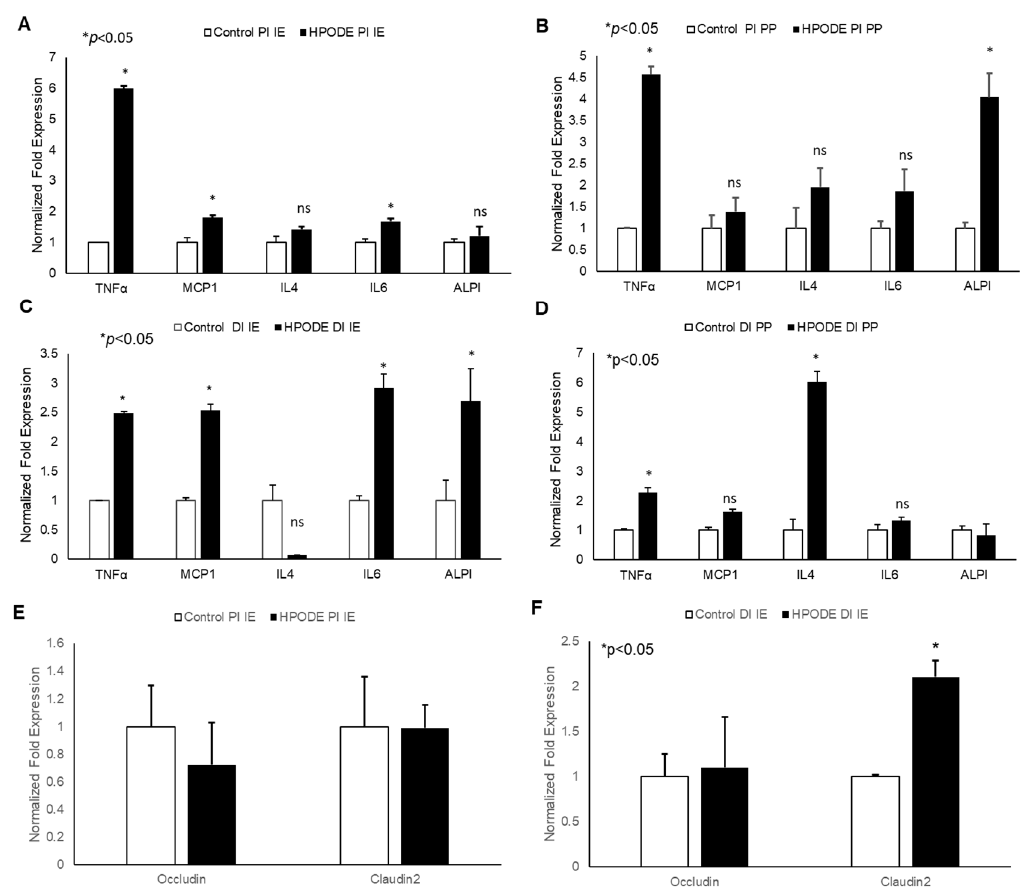
Figure 4. Acute effect of 13-HPODE on murine proximal and distal IE and PP. In acute studies, C57BL/6J mice received either PBS (control group) or 13-HPODE (HPODE group) via oral gavage and were euthanized after 4 h. Following sacrifice, the small intestine was collected, proximal (PI) and distal (DI) portions were separated, from which intestinal epithelium (IE) and Peyer’s patches (PP) were collected. ( A , B ) PI-, ( C , D ) DI-Gene expression of pro-inflammatory and ( E , F ) permeability markers in PI/DI IE and PP were assessed by qPCR. Results are represented as mean ± SEM and significance was considered as * p < 0.05, ns: not-significant. TNF- α , Tumor necrosis factor alpha; MCP-1, Monocyte chemoattractant protein-1; IL, Interleukin; ALPI, Intestinal alkaline phosphatase; PI, Proximal intestine; DI, Distal intestine; IE, Intestinal epithelial tissue; PP, Peyer’s patches.